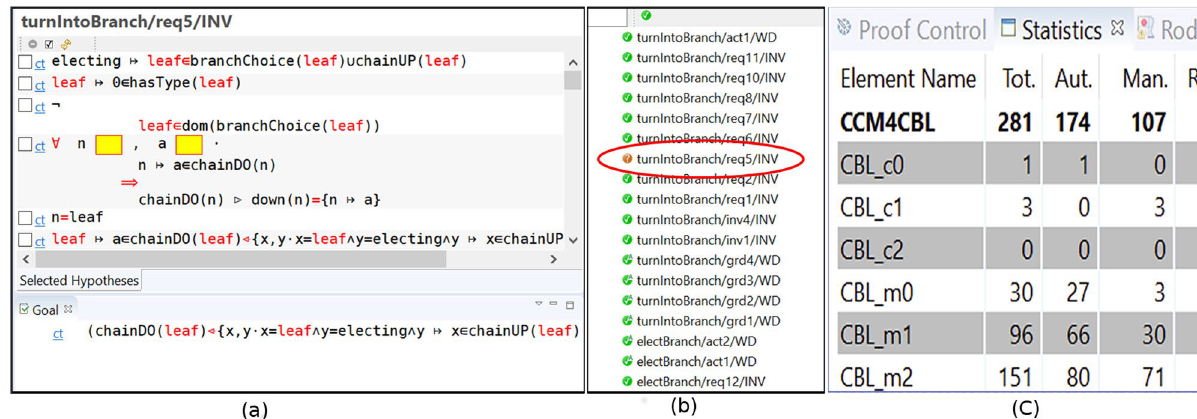
Figure 13. Examples of proof obligations and proof statistics in